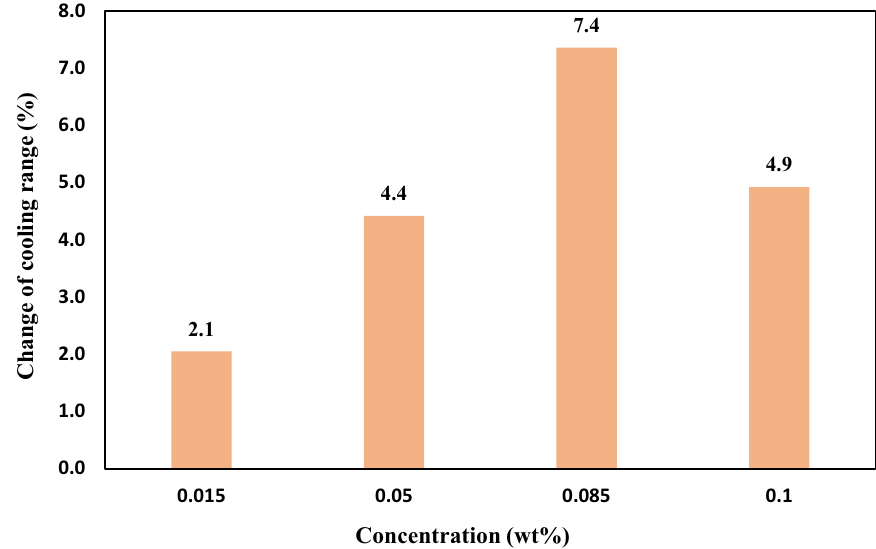
Figure 10. The effect of using nanofluid on the average cooling rates of five flow rates Using specified concentrations of TiO 2 nanofluid relative to water.